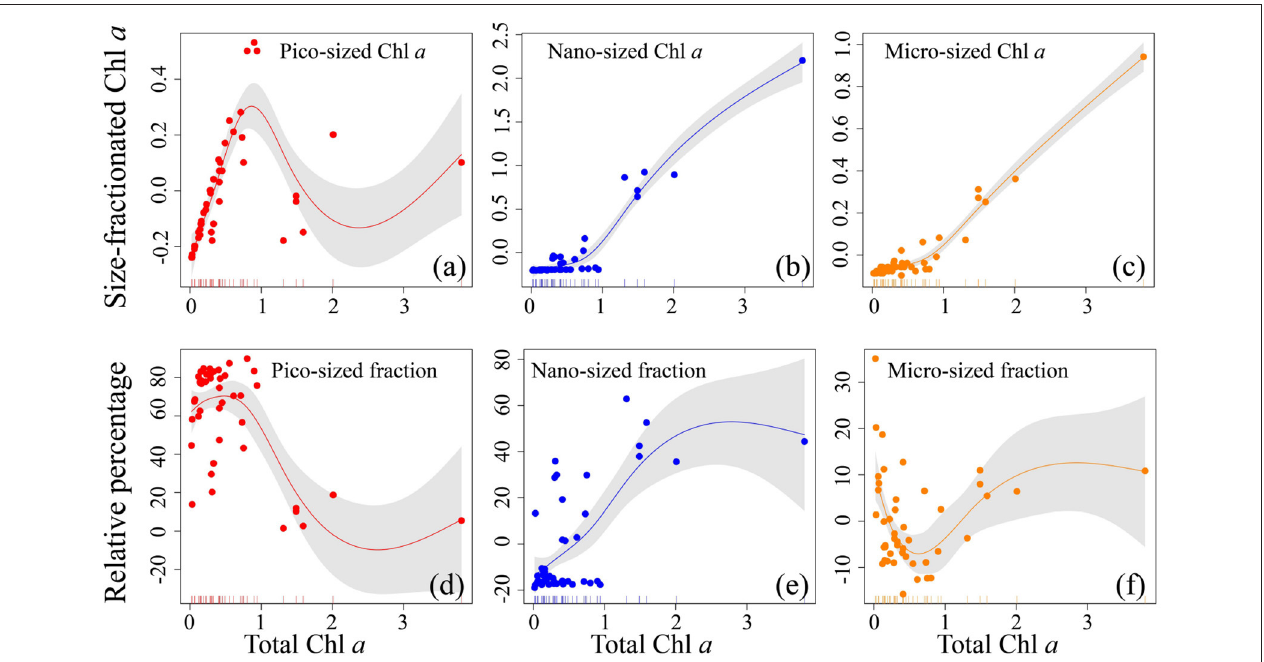
FIGURE 4 | Relationship for all size-fractionated filtration data collected in the Yellow Sea and Western Pacific. Top row (a–c) shows the absolute size-fractionated Chl a concentrations ( µ g L − 1 ), and bottom row (d–f) is the fractions (%) plotted as a function of total Chl a ( µ g L − 1 ), with the GAMs overlain. The colored dots represent residual values (that are normalized by the GAMs) of both size-fractionated Chl a and relative percentages, and the inward tick marks on the horizontal axes show data distributions. The solid lines represent GAMs smoothing, and shaded areas denote 95% confidence